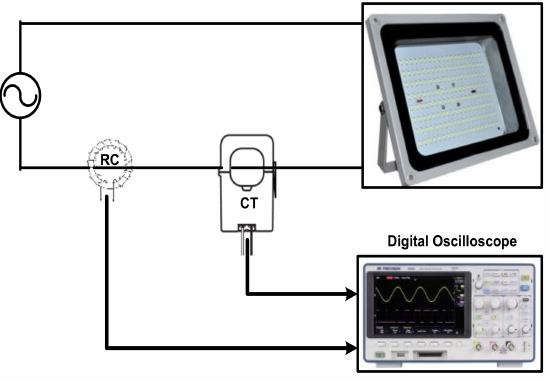
Figure 12. Schematic Diagram of the Experimental Setup to Measure the LED Luminaire